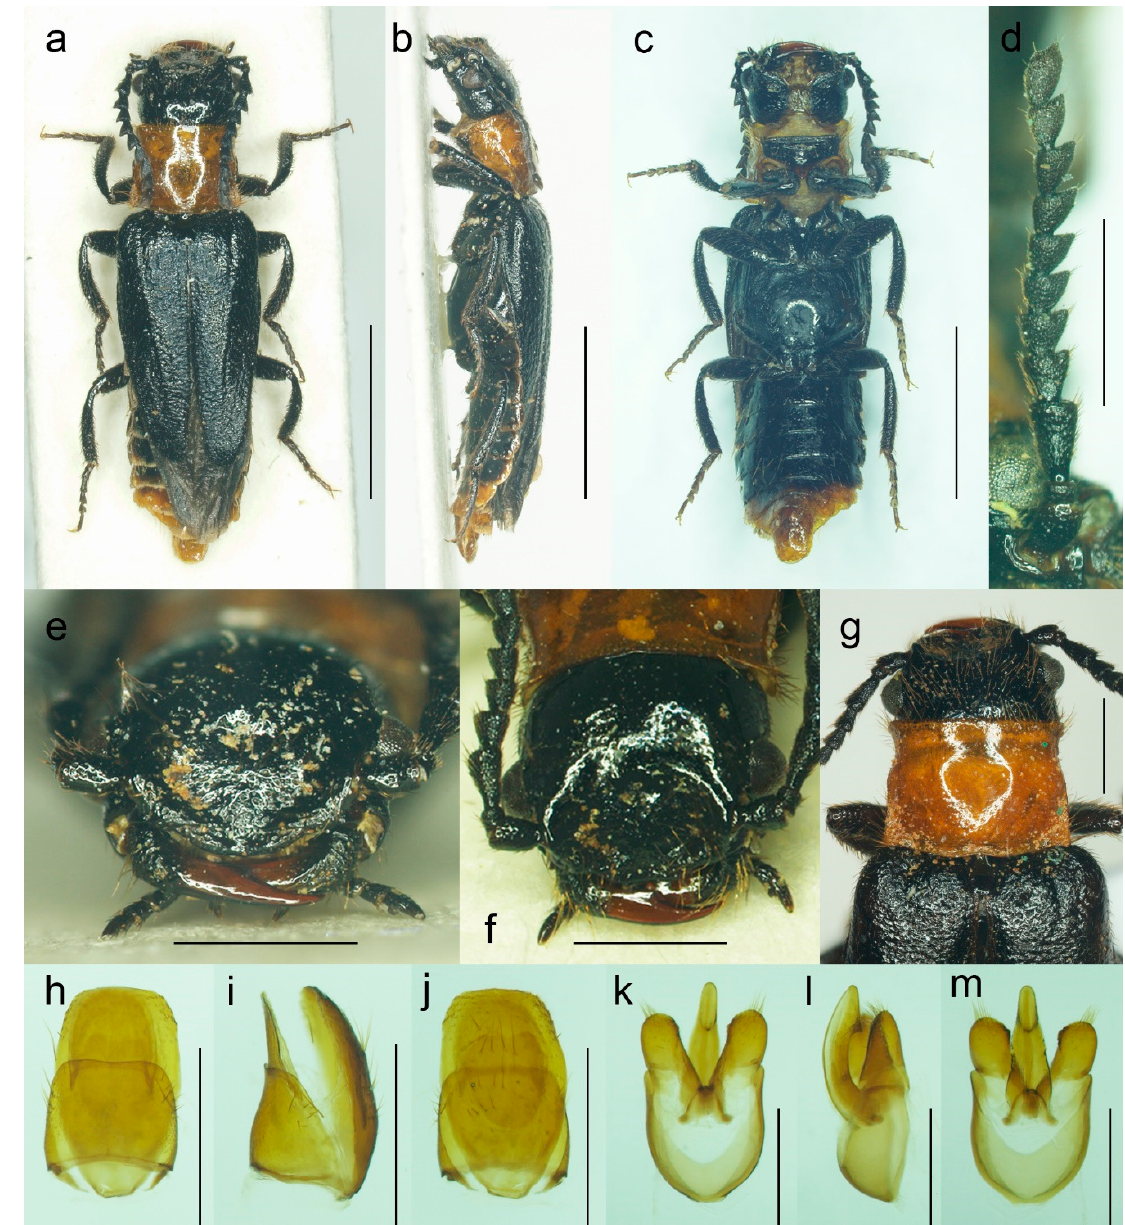
Figure 20. Malacogaster ruficollis Dodero, 1925, stat. nov., male. ( a ) Habitus, dorsal view; ( b ) habitus, lateral view; ( c ) habitus, ventral view; ( d ) left antenna; ( e ) head, frontal view; ( f ) head, fronto-dorsal view; ( g ) pronotum, dorsal view; ( h ) genital capsule formed by tergites IX and X, and sternite IX, dorsal view; ( i ) genital capsule formed by tergites IX and X, and sternite IX, lateral view; ( j ) genital capsule formed by tergites IX and X, and sternite IX, ventral view; ( k ) aedeagus, dorsal view; ( l ) aedeagus, lateral view; ( m ) aedeagus, ventral view. Scale bars = ( a – c ) 3.0 mm; ( d – j ) 1.0 mm; ( k – m ) 0.5 mm.